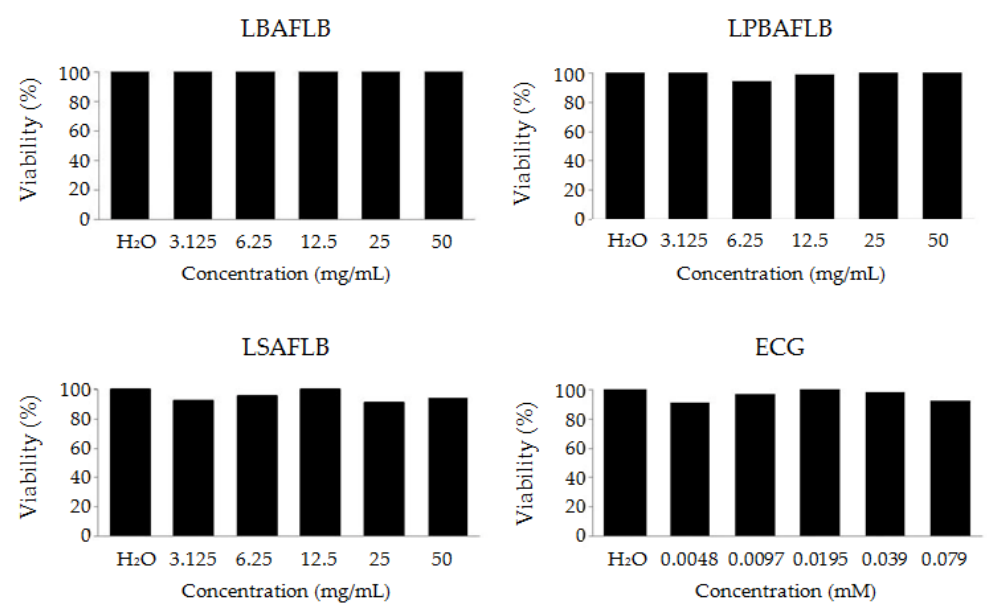
Figure 1. Toxicity levels of lyophilised blond alcohol-free beer (LBAFLB), lyophilised pale-blond alcohol-free beer (LPBAFLB), lyophilised stout alcohol-free lager beer (LSAFLB) and epicatechin gallate (ECG) in D. melanogaster. Data are expressed as percentage of surviving adults with respect to 300 untreated 72-hour-old larvae from three independent experiments treated with different concentrations of LBAFLB, LPBAFLB, LSAFLB and